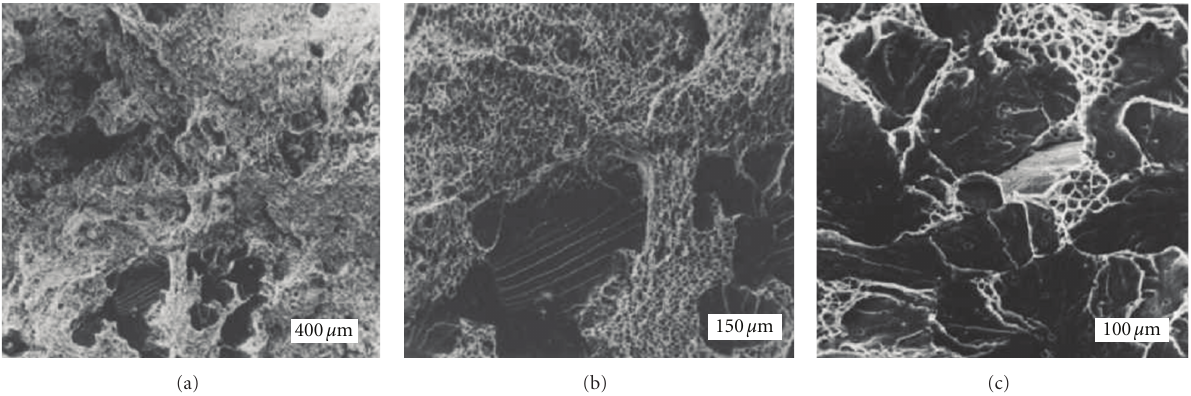
Figure 4: Fractography of the iron grade OSCh 6-2 with 3.6% porosity specimens: (a) × 75; (b) × 200; (c) ×